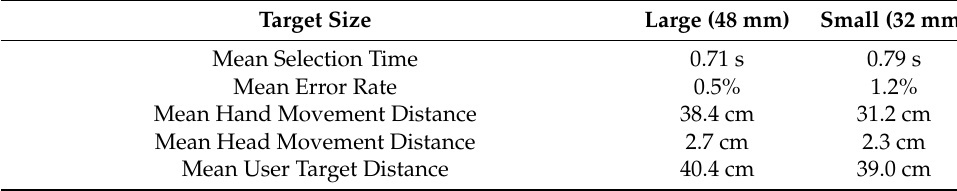
Table 1. The comparison of user performance measurements of large and small target